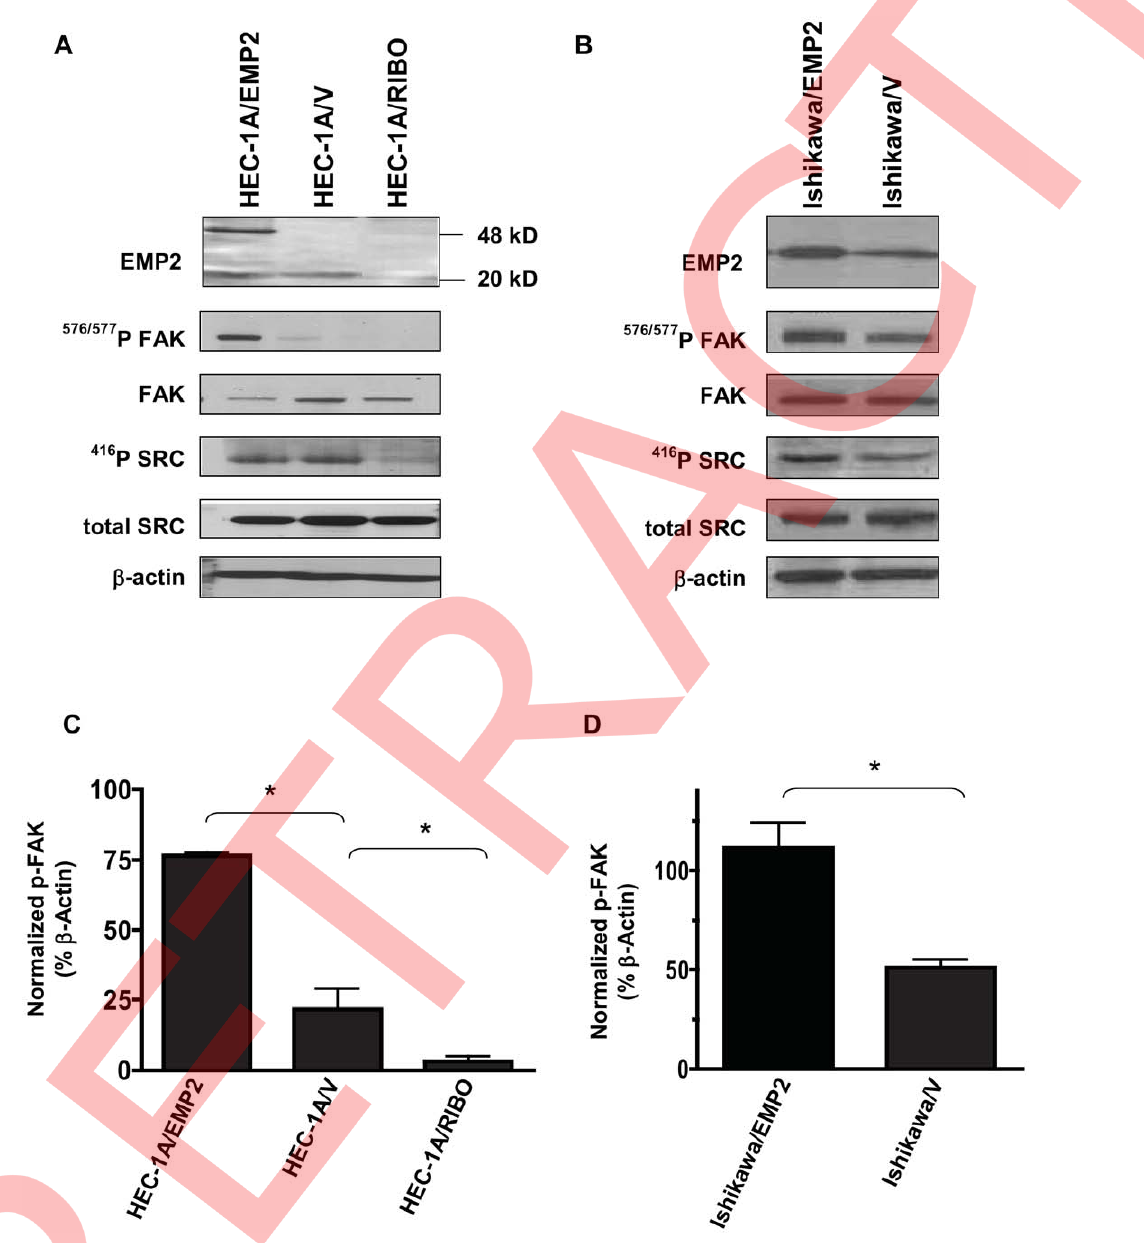
Figure 3. EMP2 promotes activated FAK and Src expression. Expression of EMP2, 576/577 P-FAK, and 416 P-Src were assessed in (A) HEC-1A/EMP2, HEC-1A/V and HEC-1A/RIBO cells or (B) Ishikawa/EMP2 and Ishikawa/V cells. Semi-quantitative analysis of 576/577 P-FAK after correction for total FAK in both HEC-1A (C) and Ishikawa cells (D) from three independent experiments, respectively. β-actin expression was used as an additional loading control. Comparison by Student's t test, * p<0.05. EMP2 and β-actin panels of Figure 3A are excluded from this article's CC-BY license. See the accompanying retraction notice for more information.